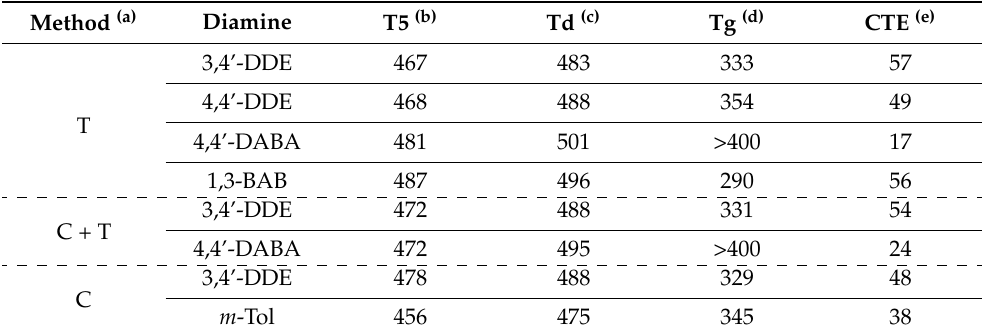
Table 2. The thermal properties of the polyimide films prepared from CpODA and aromatic diamines by three different